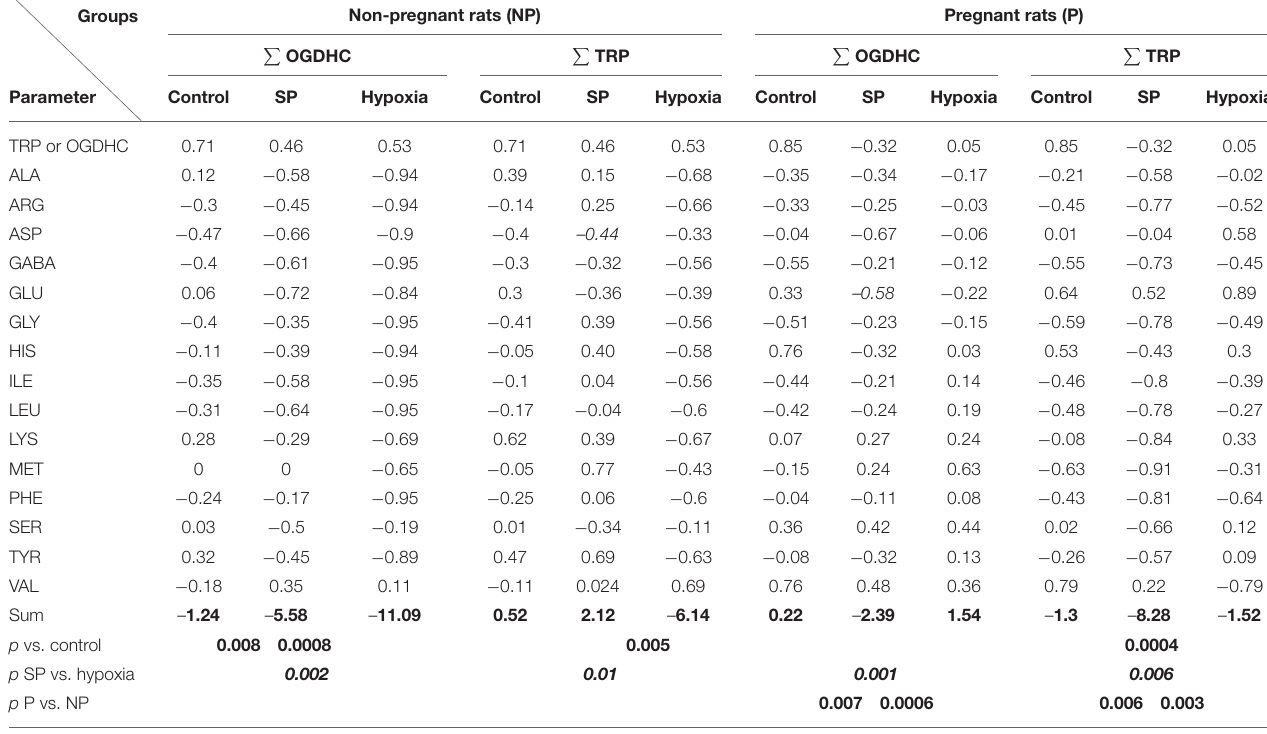
P OGDHC—the algebraic sum of correlation coefficients of the OGDHC activity and each of the amino acids. P TRP—the algebraic sum of correlation coefficients of tryptophan and each of the other amino acids or OGDHC activity. NP rats: control n = 17, SP n = 13, hypoxia n = 8. P rats: control n = 8, SP n = 11, hypoxia n = 10. The three bottom lines show p values of the statistically significant (p < 0.05) differences between the indicated groups, estimated by the Wilcoxon signed rank test. The strength of the negative correlations is estimated by the algebraic sum of correlation coefficients of OGDHC or tryptophan with other components. The algebraic sums for the hypoxic rats have been calculated using the published data (9). The parameters exhibiting statistically significant differences and the corresponding p-values are marked in bold. The p-values at the level of a trend are shown in